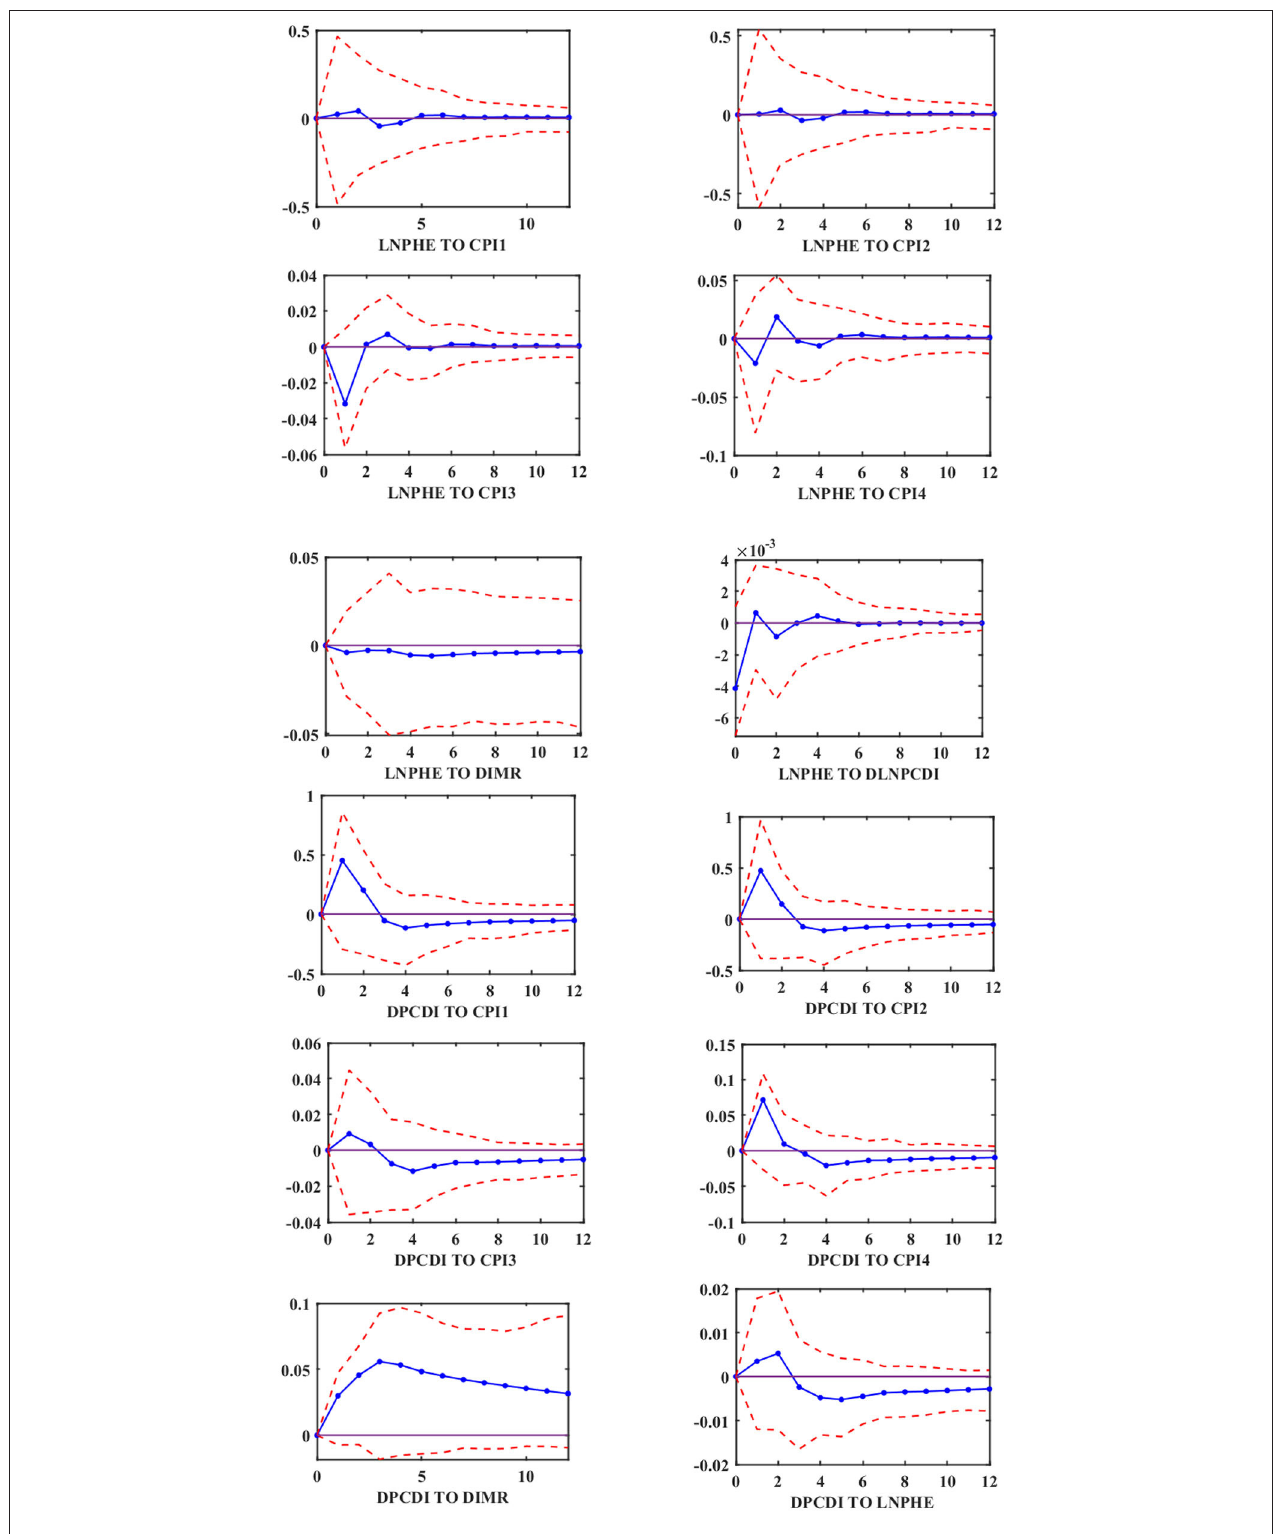
FIGURE 3 | Impulse response functions based on MF-VAR.